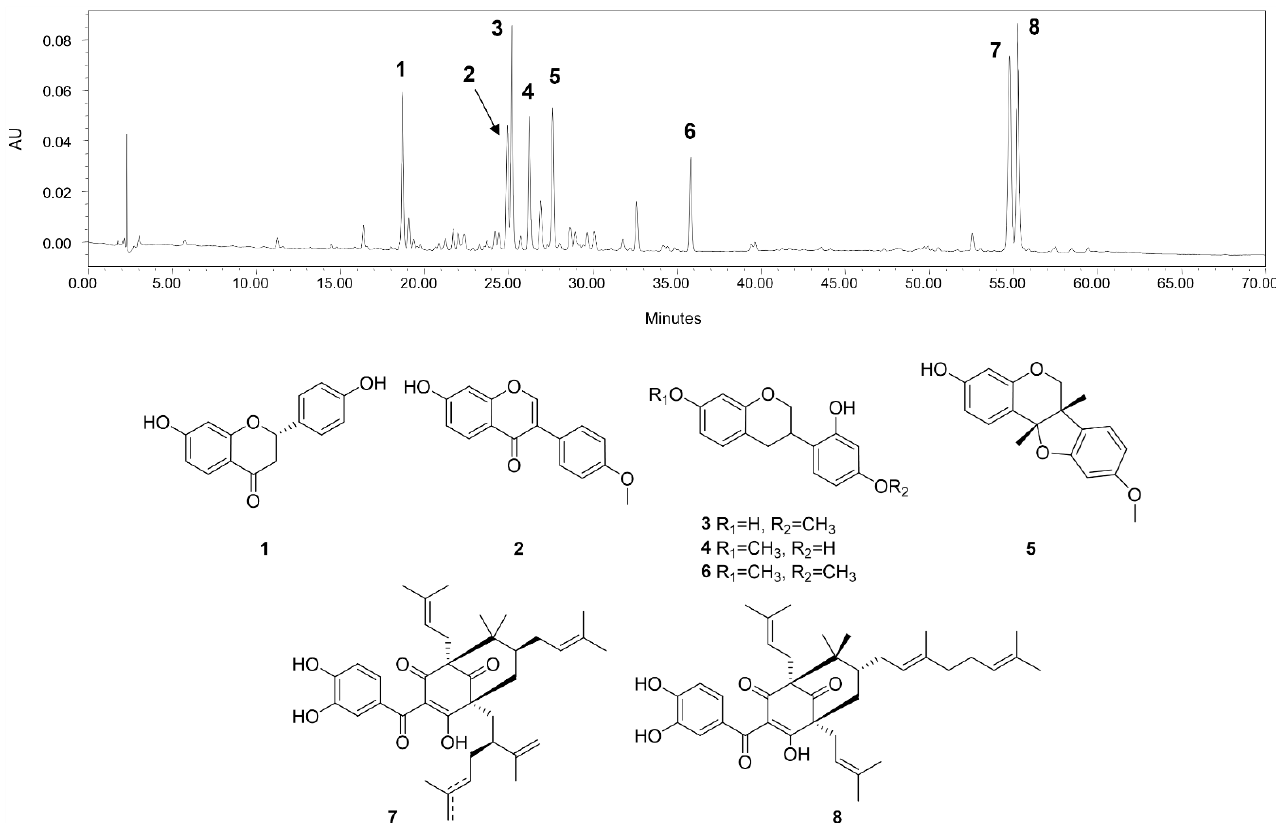
Figure 1. HPLC chromatographic profile (275 nm) and chemical structures of the main compounds identified in CHEBRP. Numbers correspond to liquiritigenin ( 1 ), formononetin ( 2 ), vestitol ( 3 ), neovestitol ( 4 ), medicarpin ( 5 ), 7-O-neovestitol ( 6 ), guttiferone E ( 7 ), and oblongifolin B ( 8 ).